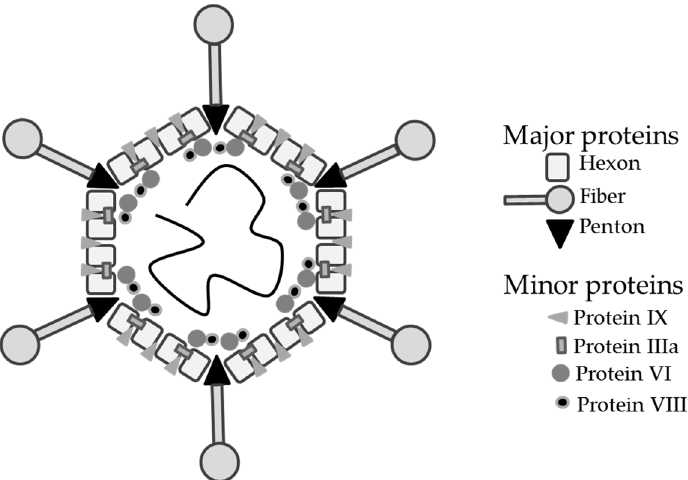
Figure 1. Adenoviral capsid. Schematic representation of an icosahedral AdV capsid organization with double-stranded DNA genome (black spiraling line). The outer capsid shell consists of three major capsid proteins hexon, fiber and penton base, and four minor capsid elements pIX, pIIIa and protein VI and VIII.